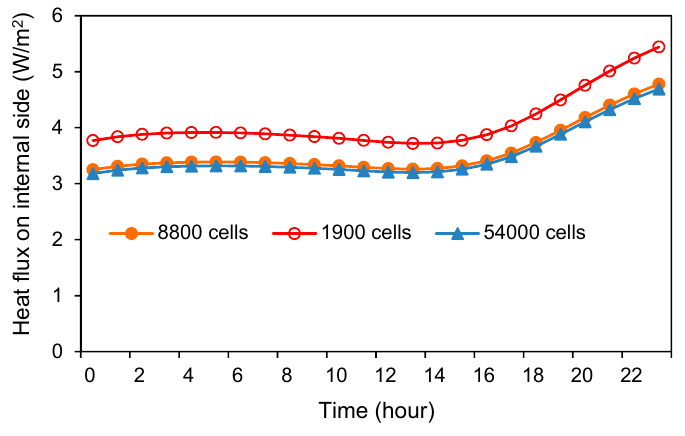
Figure 4. Results from different mesh densities.